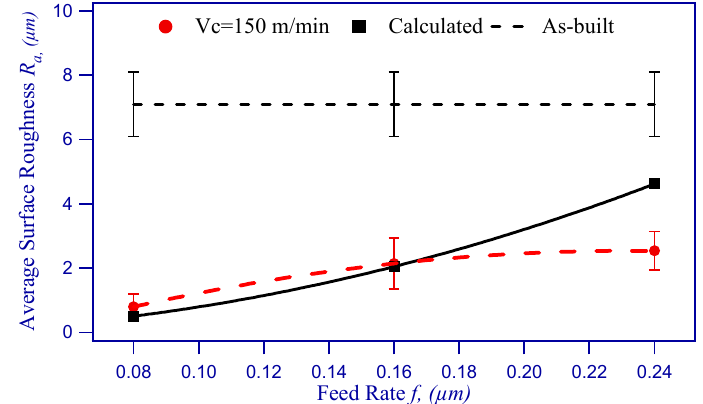
Figure 9. Surface roughness of finish-machined SLMed 316L stainless steel as a function of the feed rate.